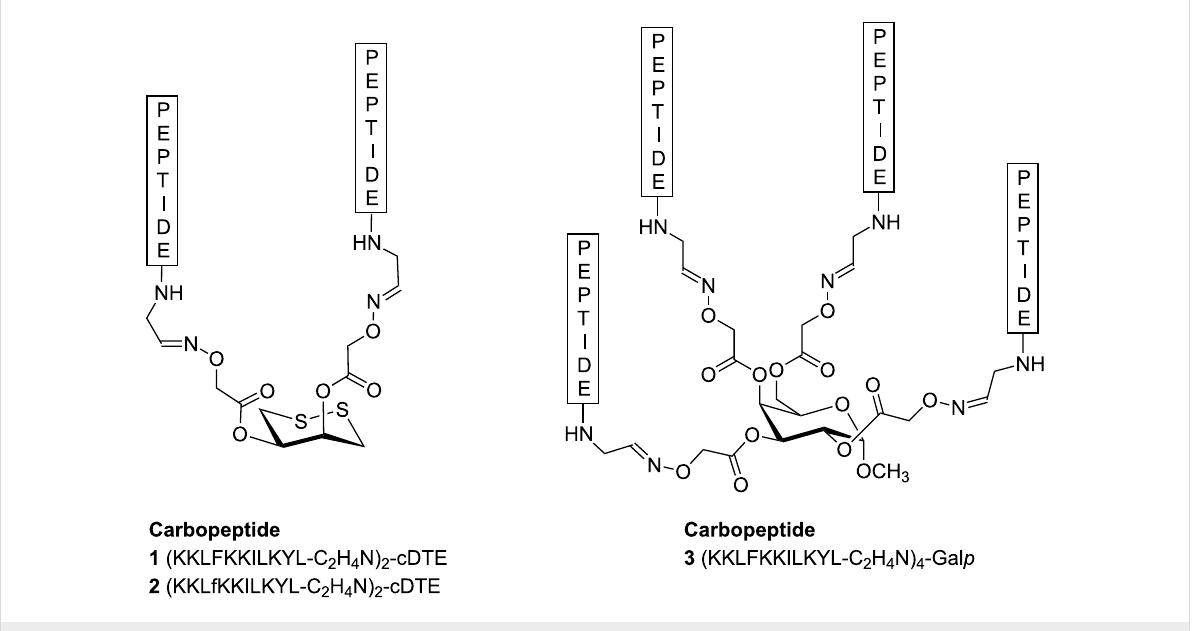
Figure 1: Structure of the carbopeptides 1 – 3 .